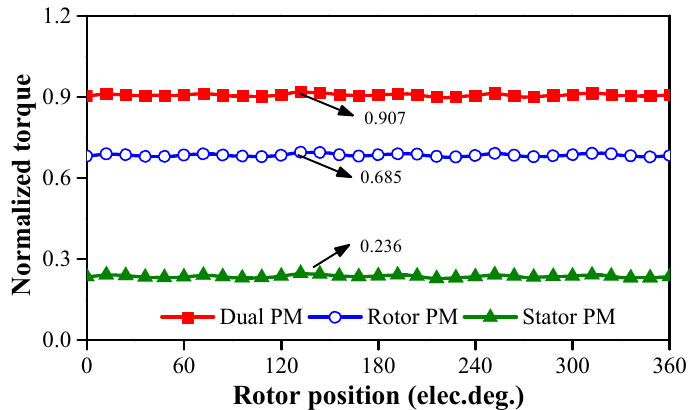
Figure 5. Torque decomposition of 12S11R1Pa SSDPM machine when relative permeability is 50. Table 1. Parameters of optimized SSDPM machines with different slot/pole number combinations.